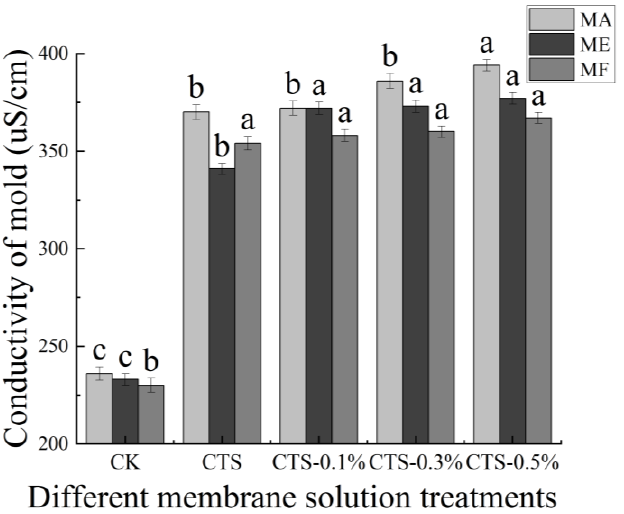
Figure 5. Effect of different concentrations of composite membrane solution on conductivity of mold. The bars on the columns indicate standard deviation. Different letters indicate significant differences ( p < 0.05) within an experiment (marked with letters).